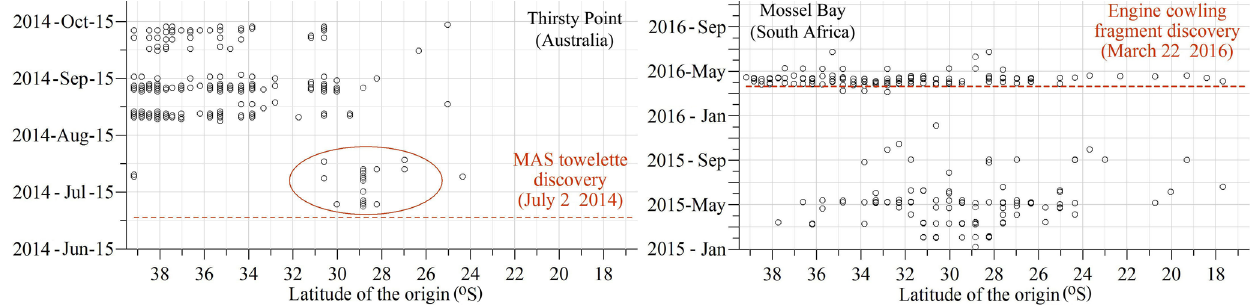
Figure 12. Arrival times of particles to the proximity of Thirsty Point (Australia) during 2014 and Mossel Bay (South Africa).